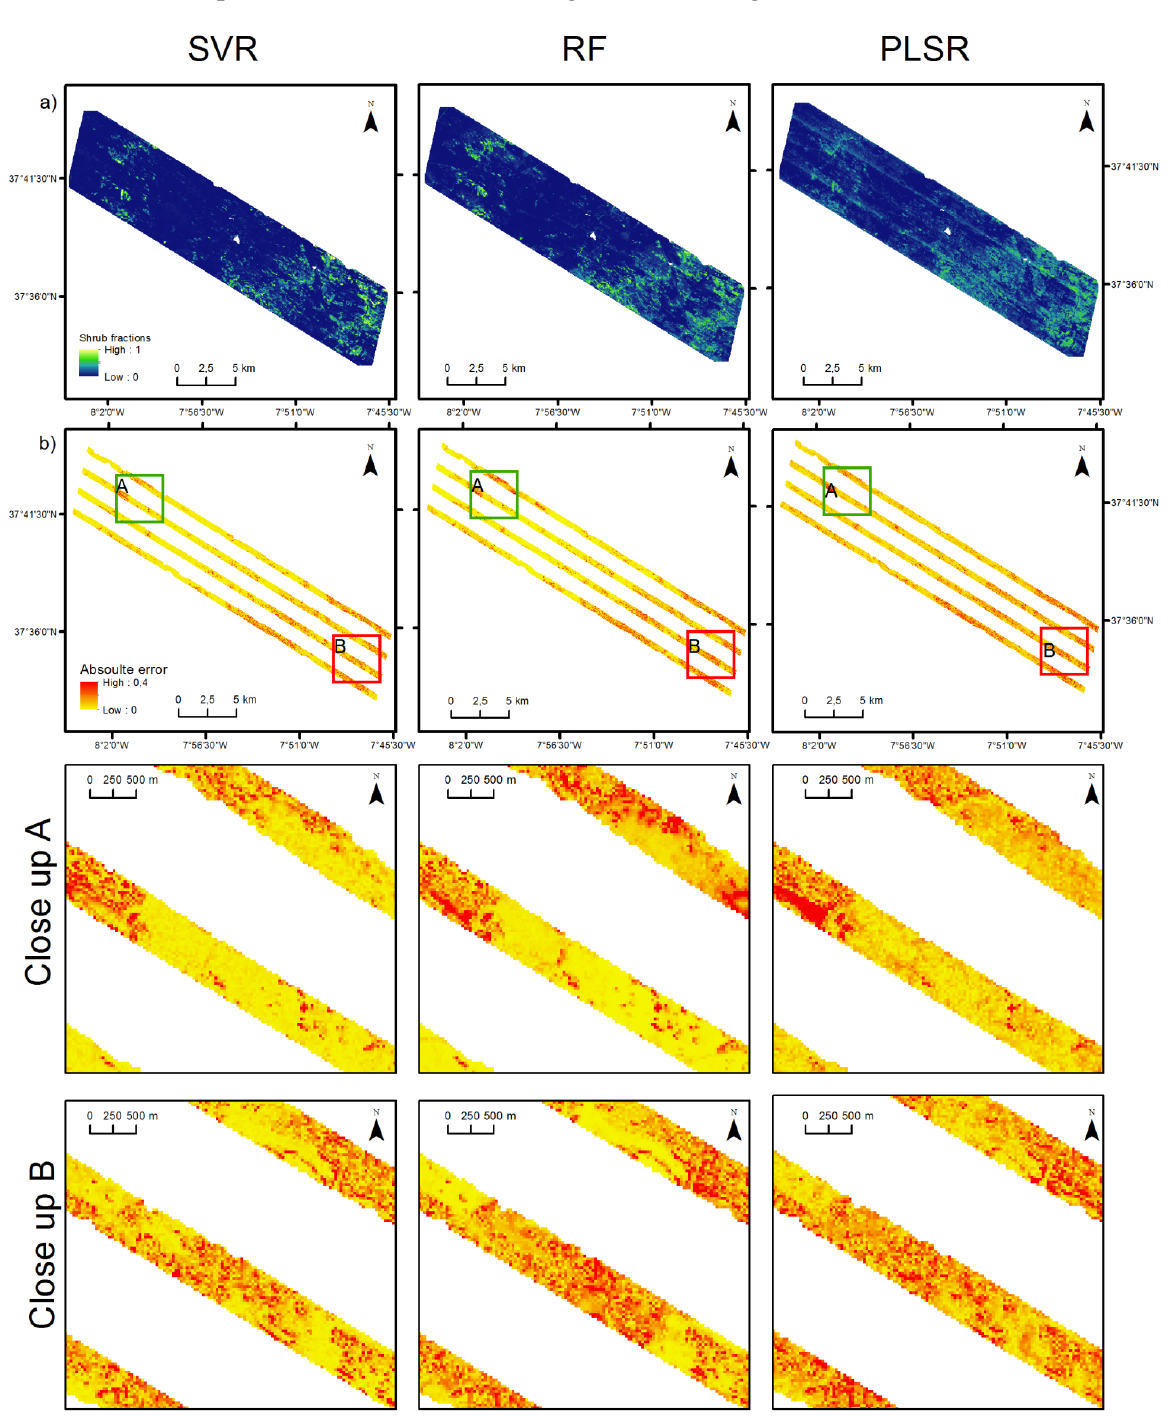
Figure 5. ( a ) Shrub cover maps based on SVR, RF and PLSR models using 1000 sample points. Blue colors indicate low, green to yellow colors high shrub cover fractions; ( b ) Error maps between the observed and predicted shrub cover fractions for every algorithm. Yellow colors indicate low errors, red high errors. Close ups A and B show details of the spatial prediction accuracy in regions with sparse ( A ) and dense ( B ) shrub cover. In all maps the white areas indicate regions of missing